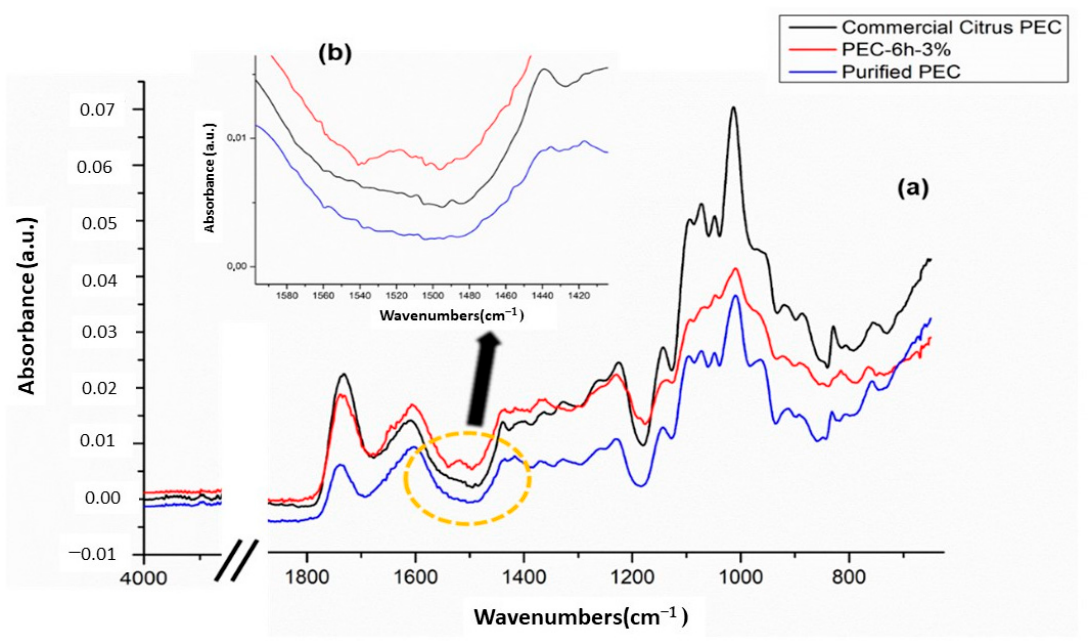
Figure 3. FTIR-ATR spectrum of all pectin samples ( a ) and the presence ( b ) of bioactive molecules peak.